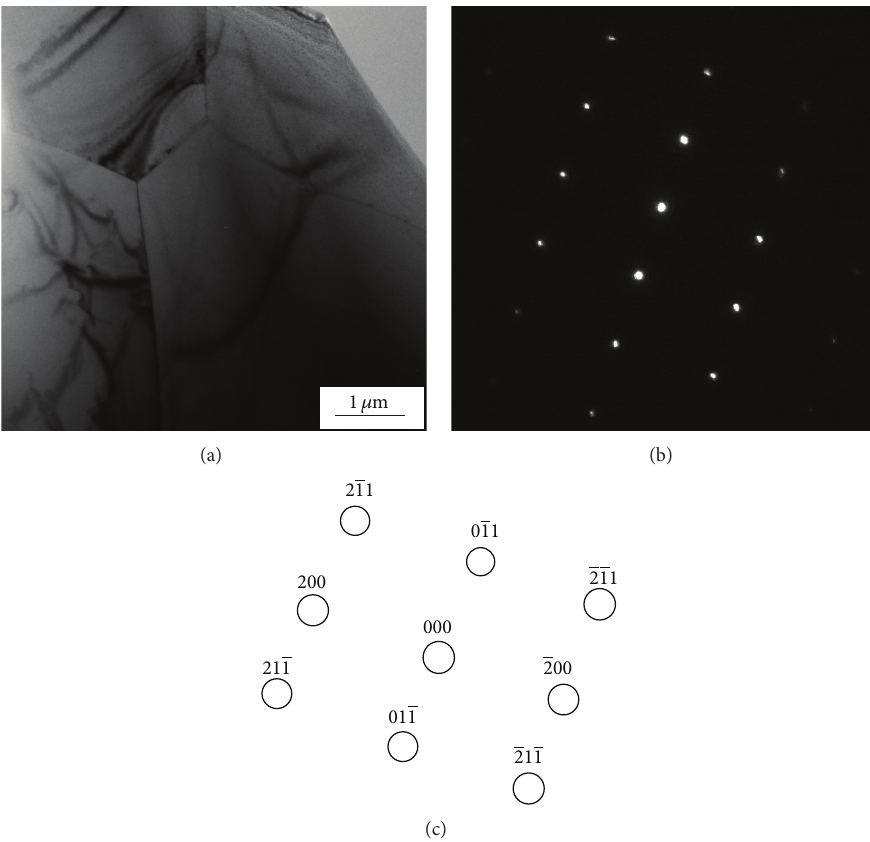
Figure 4: TEM micrographs of the as-spinned Fe-6.5wt.%Si ribbons. (a) Bright-field image; (b) SADP of the zone axis of [001] ; (c) the corresponding schematic illustration, where only A2 phase is identified.